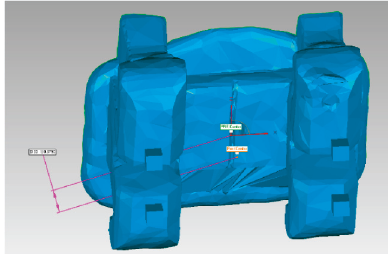
Figure 10: Measurement of the linear deviation between the preoperative and postoperative STL